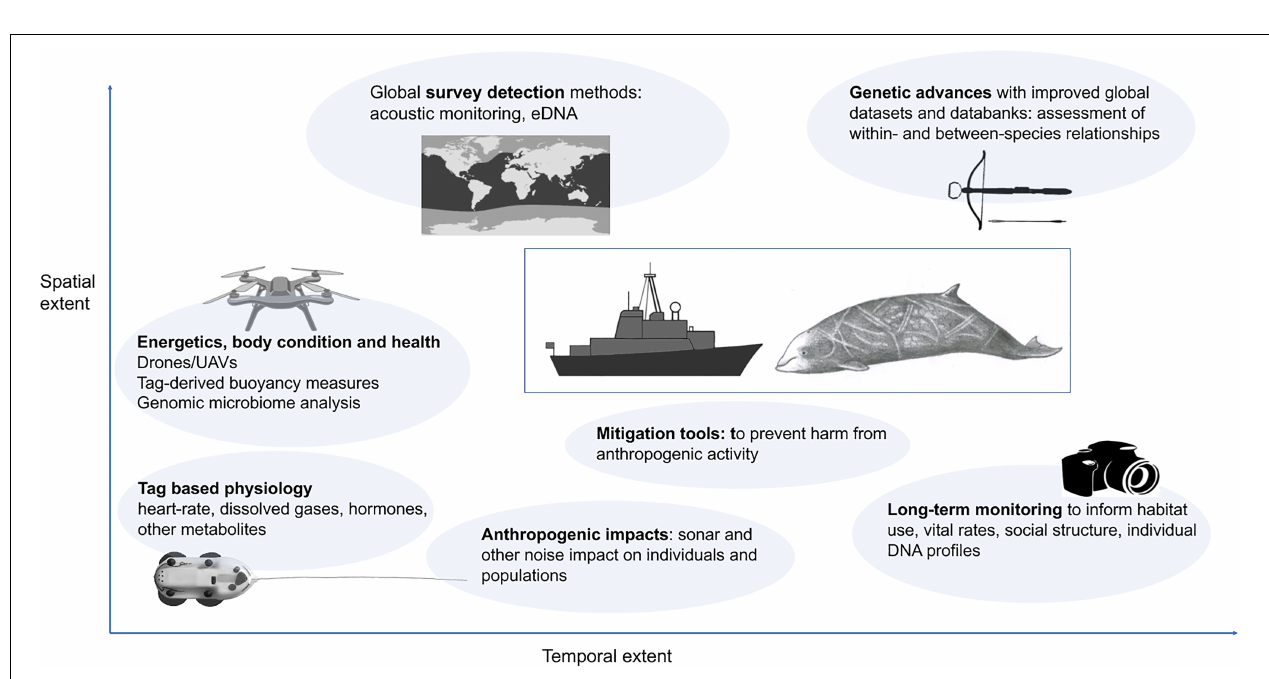
FIGURE 2 | Suggested future directions for beaked whale research vary in terms of both spatial and temporal extent. See text for more information on each.